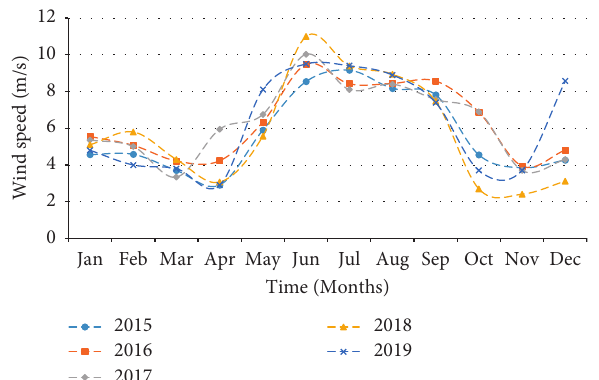
Figure 4: Variation of monthly wind speed.